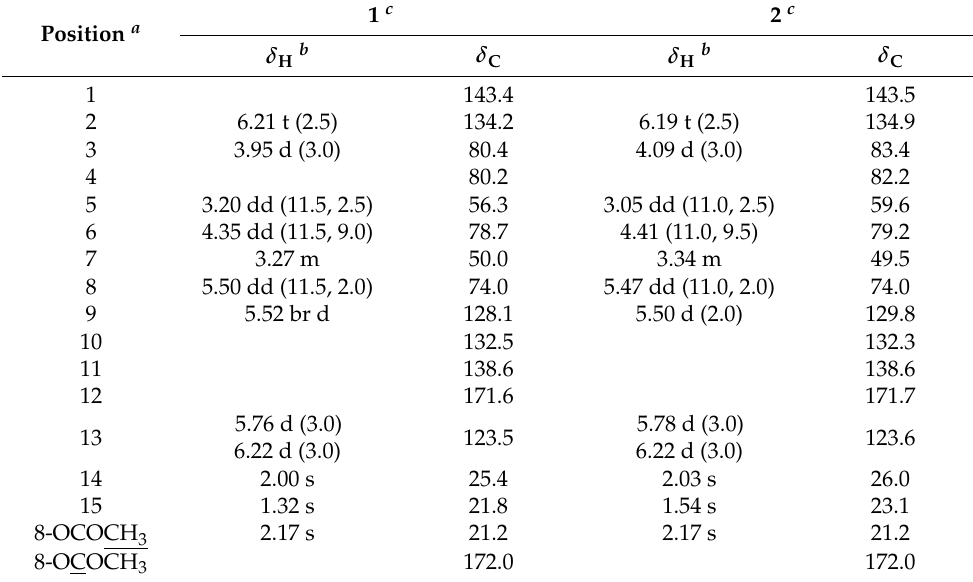
Table 1. 1 H- and 13 C-NMR spectroscopic data of compounds 1 and 2 .